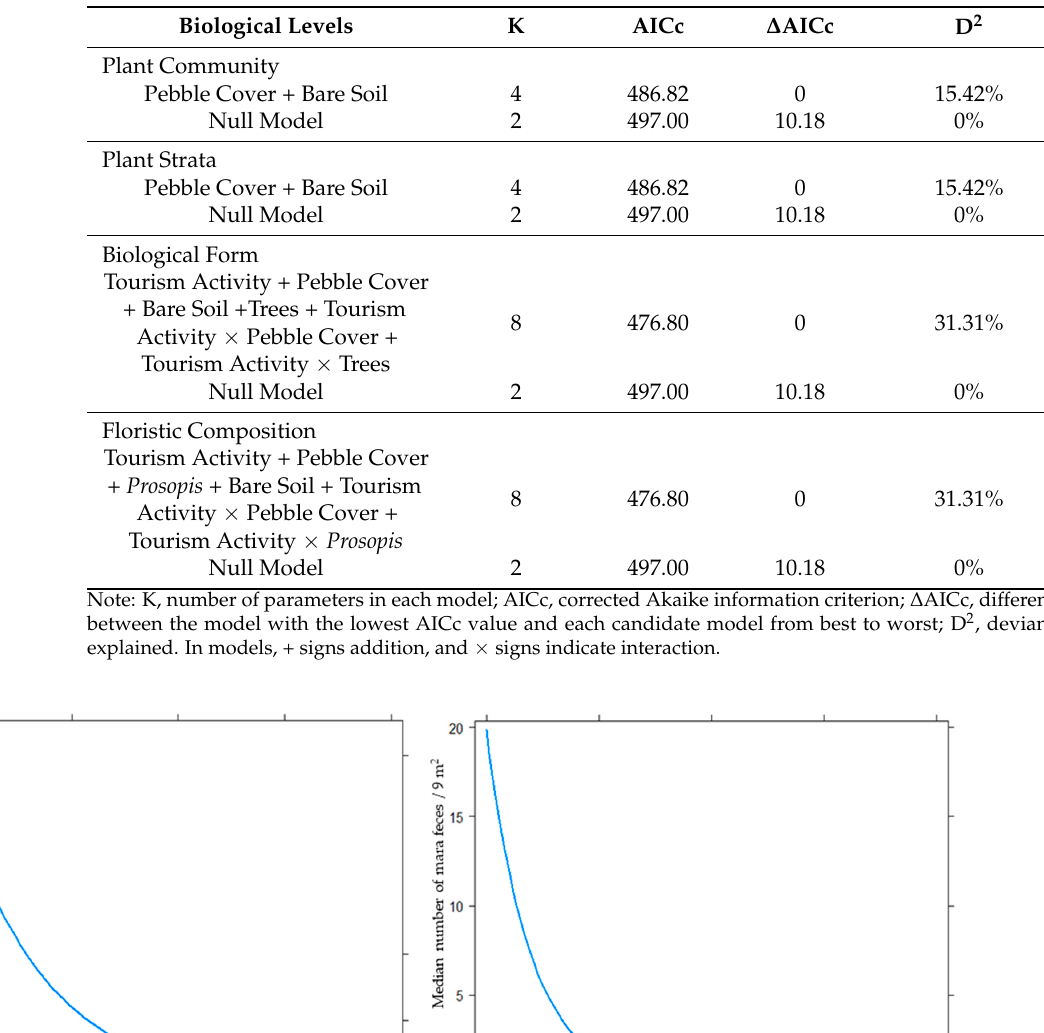
Figure 4. Interaction of tourism activity and tree cover with habitat use of maras ( Dolichotis pata- gonum ), measured as median number of mara feces by quadrat (3 m × 3 m), as a response variable, of models for biological plant forms and floristic composition levels: (a) blue line, near tourist circuit (high tourist activity), (b) pink line, distant tourist circuit (low tourist activity). 4. Discussion Contrary to what we expected, the hypothesis that current tourism intensity nega- tively affected habitat use by mara was not validated by the results obtained in this study. Our results revealed that in the Ischigualasto Provincial Park, at the community and plant strata levels, the main variables that explained the habitat use of maras were pebble cover and bare soil. These models explained up to 15.5% of the deviance observed in mara hab- itat use. When we considered the physiognomy level, the cover of different plant forms as explicative biological variables, the best model included, in addition to the abiotic var- iables (pebble and bare soil cover), the tourist activity pressure (areas near the tourist cir- cuit vs. areas far away from it), tree cover, and the interactions between tourist activity and pebble cover, and between tourist activity and tree cover. This model explains 31.2% of the observed deviance and was the best among the models developed for the four bio- logical levels. Finally, when we included the floristic composition in the model, the best